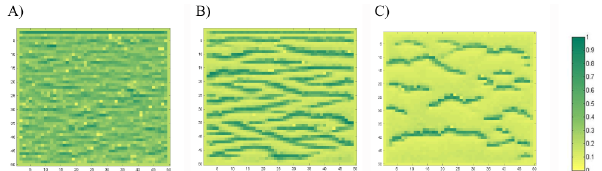
Fig. 14. Effect of net radiation on pattern formation. (A) Net radia- tion = 210Wm − 2 ; (B) Net radiation = 250Wm − 2 ; (C) Net radia- tion = 290Wm − 2